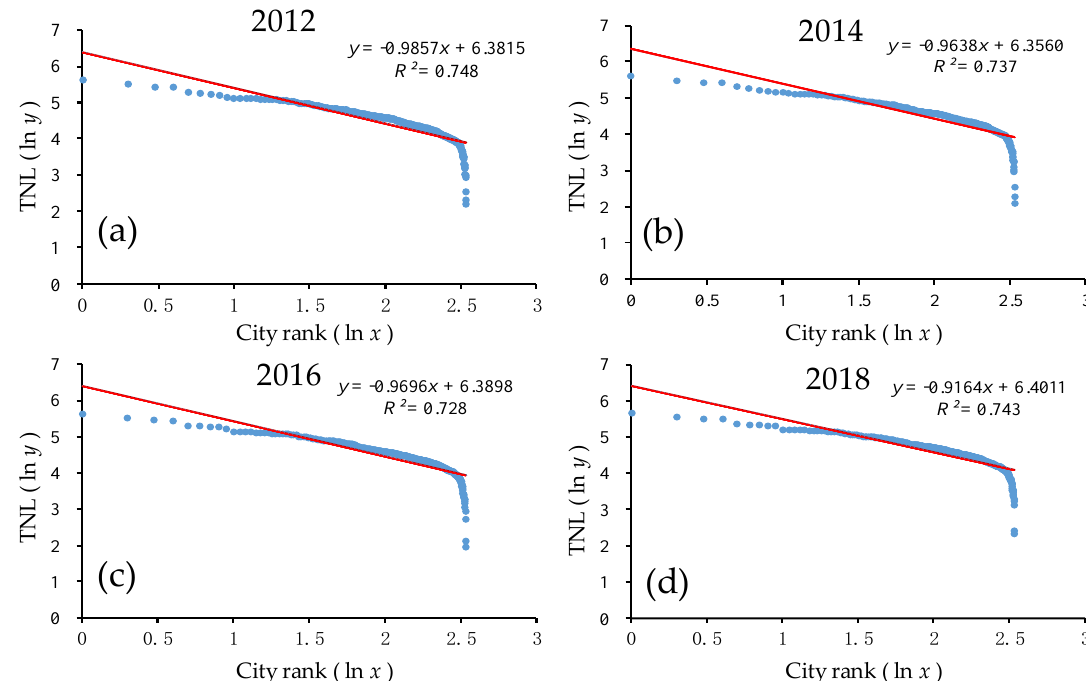
Figure 9. The ln-ln plot of the rank–size of the urban development for all prefectures. Line regression of (a) TNL and ranking of all prefectures in 2012; (b) TNL and ranking of all prefectures in 2014; (c) TNL and ranking of all prefectures in 2016; (d) TNL and ranking of all prefectures in 2018.